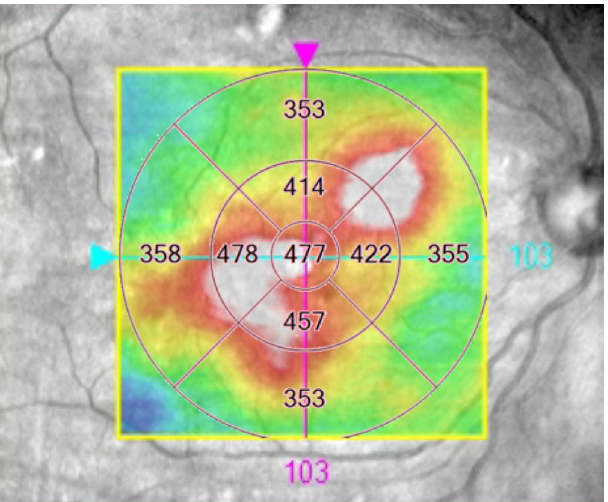
Figure 1. Optical coherence tomography (OCT) C-scan image. The Early Treatment Diabetic Retinopathy Study (ETDRS) 9 grid in 6 × 6 mm scan. The central retinal thickness (CRT) in the central subfield is automatically calculated by the software. In this study, AngioPlex OCT angiography (software version 11.0.0.20046, https ://ww.zeiss .com/medit ec/int/home.html) was